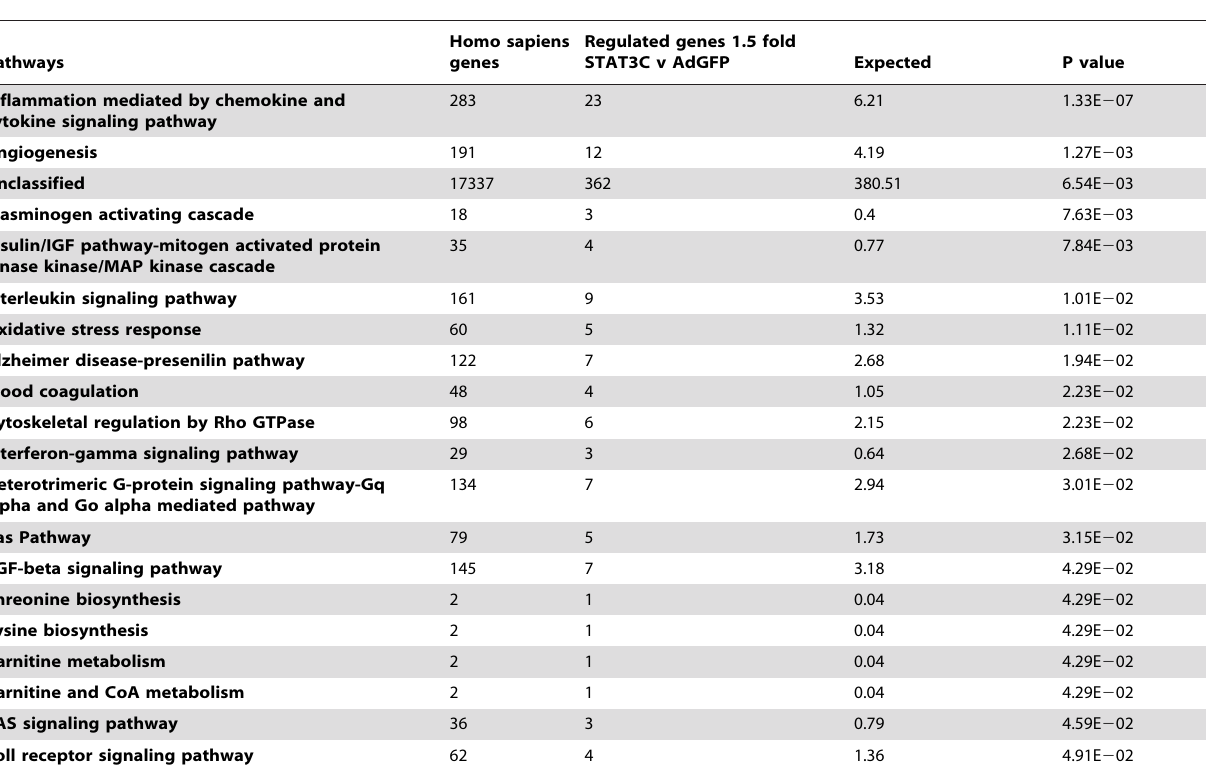
Table 3. Pathways identified by ontological analysis to be over-represented in MSC STAT3C versus MSC AdGFP.